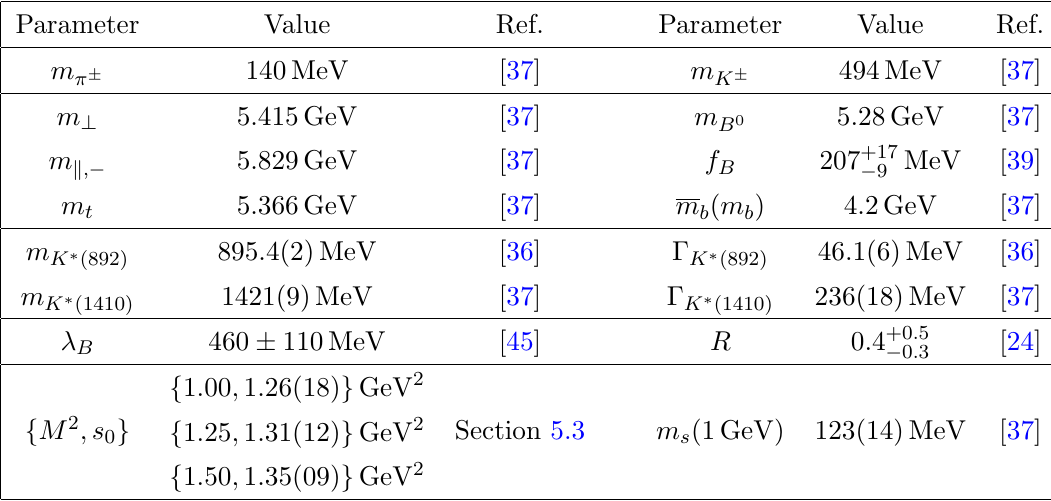
Table 2 . Compendium of numerical inputs used in the